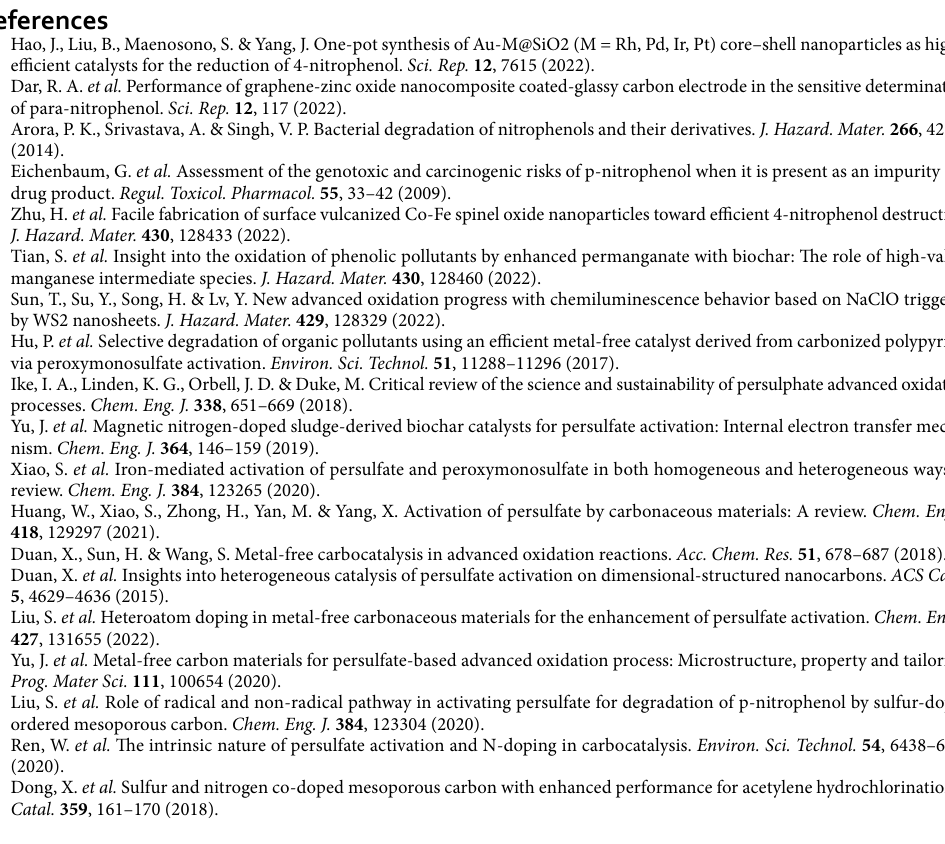
degradation. Various factors might be responsible for the high activity of (N, S)-MPC, including the porous carbon structure indicating the carbon bridge and electron transfer as well as interaction with the benzene ring, the presence of heteroatoms enhancing the electron transfer, and structural defect. Among the metal-free carbon-based materials for persulfate activation, the straightforward and low-cost synthetic procedure, and low catalyst amount make (N, S)-MPC an excellent choice for practical applications. In addition, the presented catalyst opened a promising research field for biomedical applications in which the absence of metals is highly demanded due to the lack of toxicity and higher biocompatibility including theragnostic nanomedicine. Data availability All data generated or analyzed during this study are included in this article .